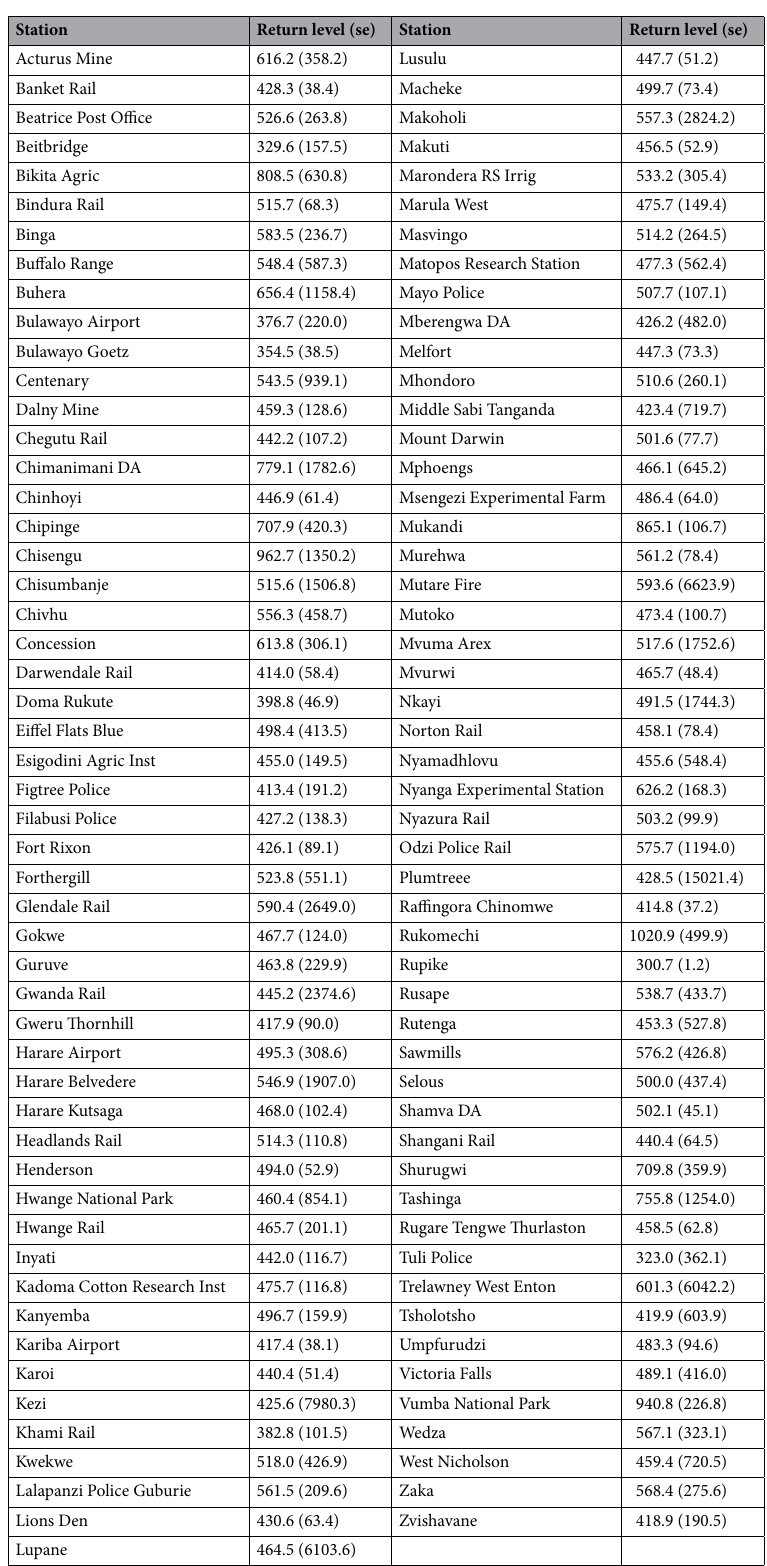
Table 3. Estimates and standard errors of 100-year return level of annual highest monthly